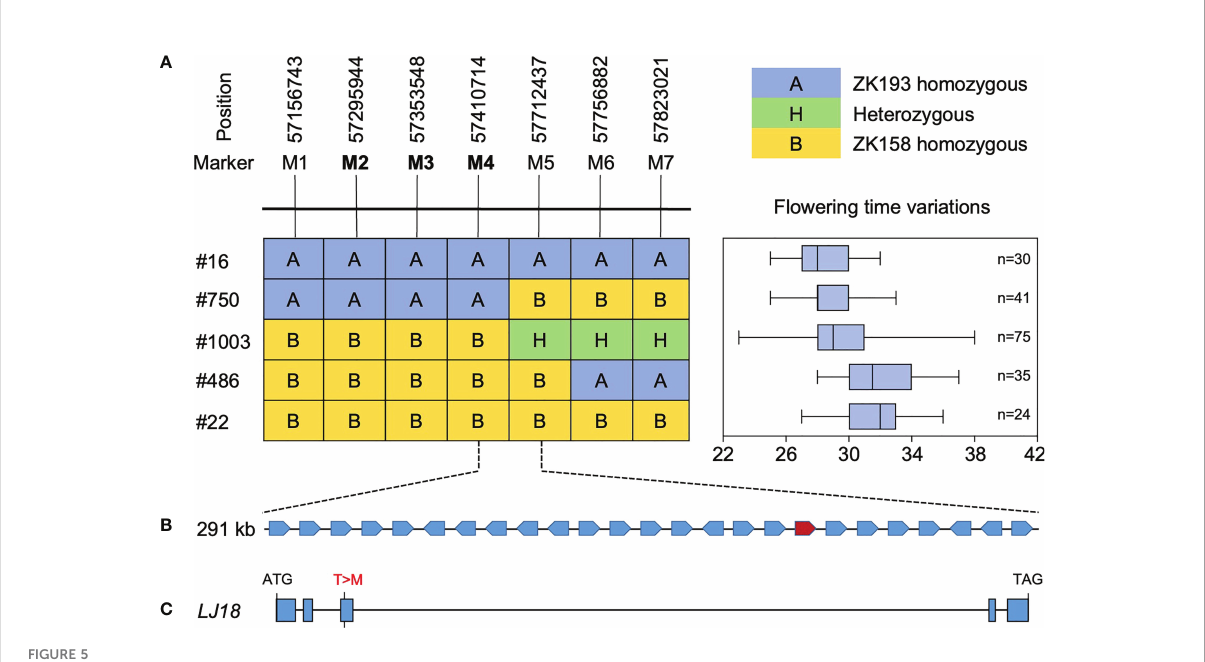
FIGURE 5 Identi fi cation of the LJ18 gene by map-based cloning. (A) Segregation of fl owering time and delimitation of the LJ18 locus to a 301-kb region between the marker M4 and M5 on chromosome 18. A, homozygous for the allele from ZK193; B, homozygous for the allele from ZK158; H, heterozygous. Segregation of fl owering time is shown in right box-plot format, where the interquartile region, median, and range are represented by the box, the bold vertical line, and the horizontal line, respectively. Each box plot corresponds to the segregant on the same row in left. (B) The delimited region contains 25 predicted genes. (C) Allelic variation in the LJ18 candidate gene Glyma.18G188800 between ZK193 and ZK158.